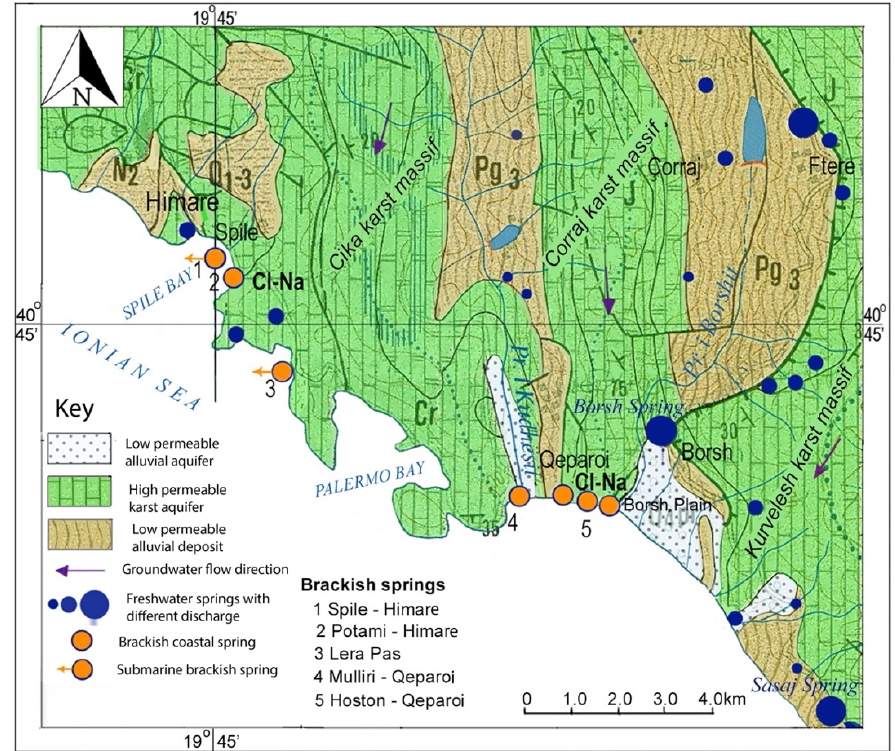
Figure 9. Hydrogeological map of Himare ‐ Qeparoi (modified after [33]).